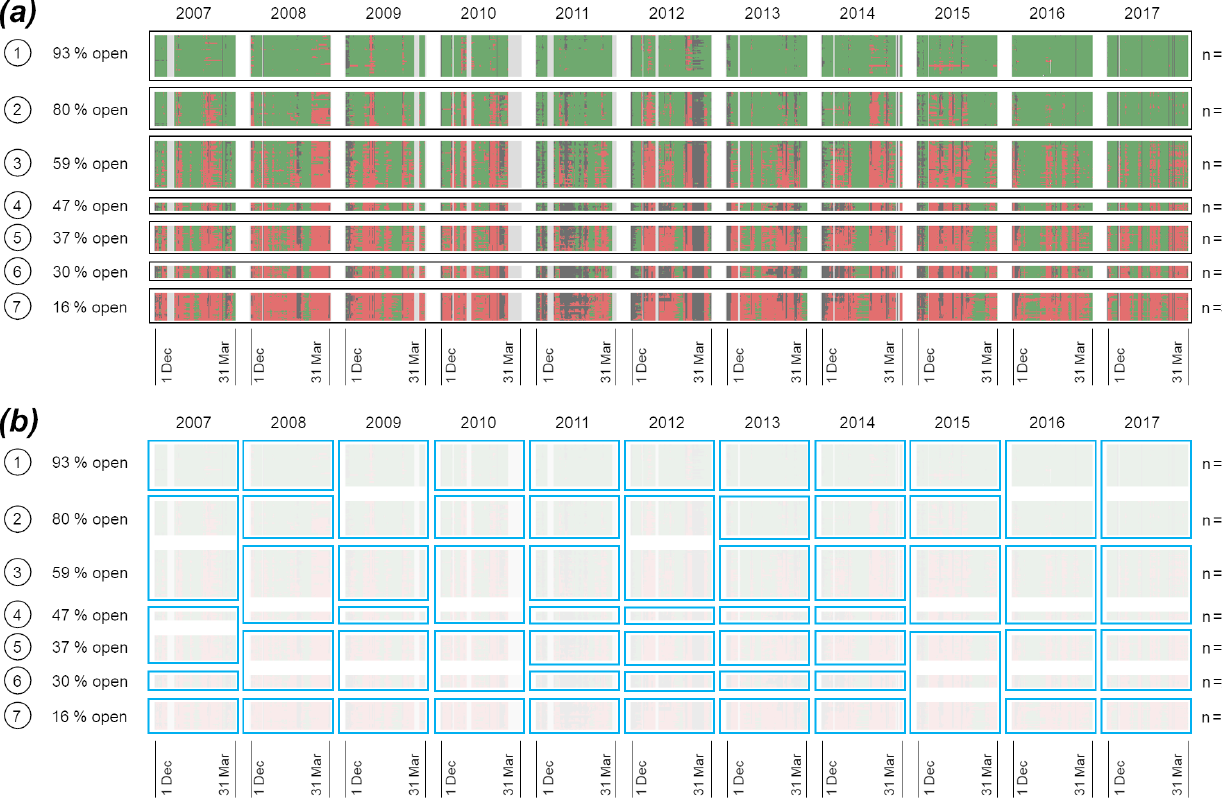
Figure 2. Identified ski run hierarchy with groups of similarly managed ski runs at CMHGL with (a) typical time series of run list ratings for the winter seasons from 2007 to 2017 and (b) inter-seasonal variation within the ski run hierarchy. The time series strips of each group consist of colour-coded rows representing the run list ratings of the individual runs included in that group. Taller strips therefore represent groups with larger numbers of runs. Days when ski runs were open are shown in green, days when they were closed due to avalanche hazard are shown in red and days when they were not discussed or closed due to non-avalanche-hazard-related reasons are shown in black. Days with no run list data at all (e.g., prior to operating season, days when operation was shut down due to inclement weather conditions) are shown in grey. Panel (b) shows the identified within-season clusters (blue boxes) with multi-season ski run classes